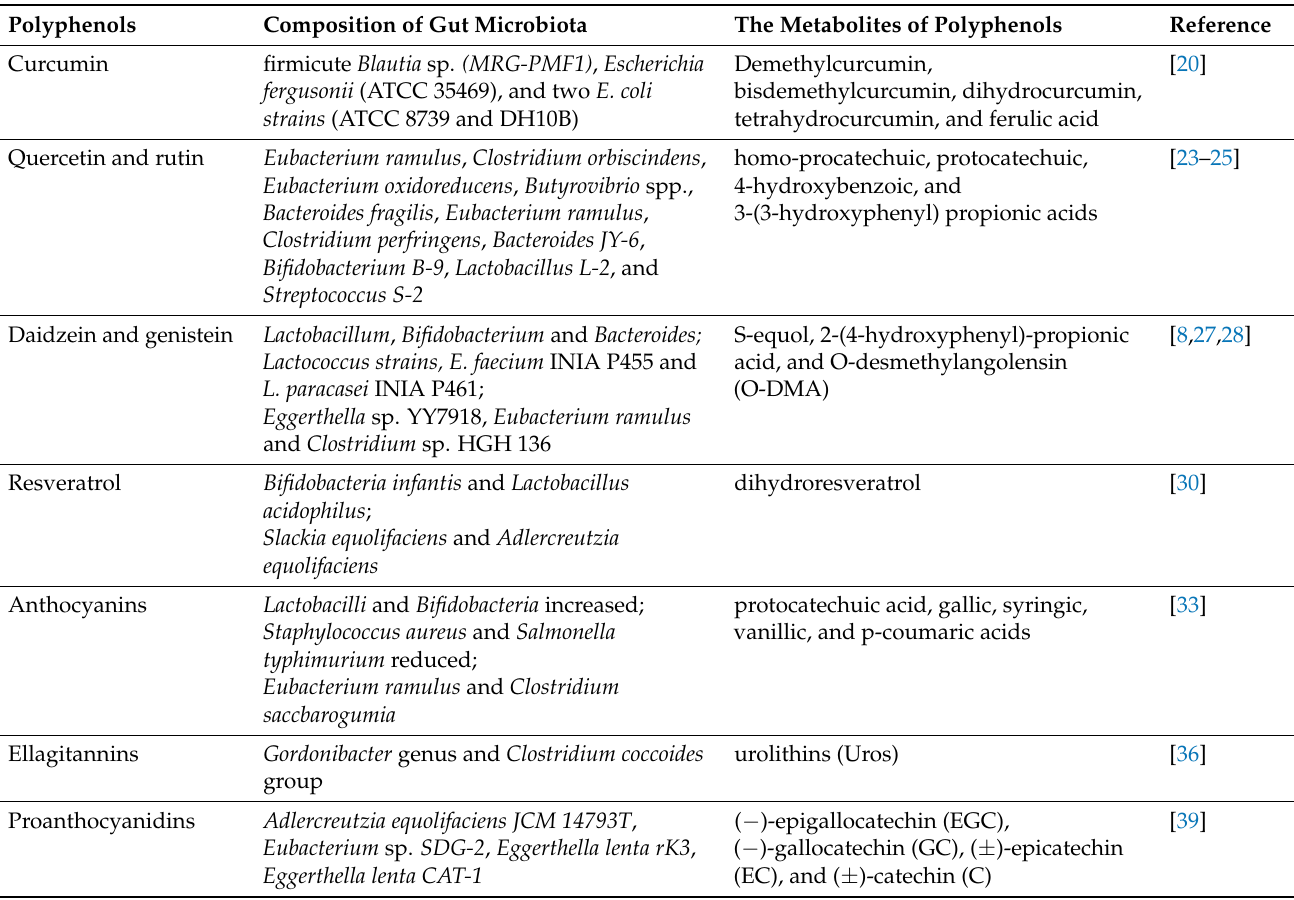
Table 1. Biotransformation of polyphenols by gut